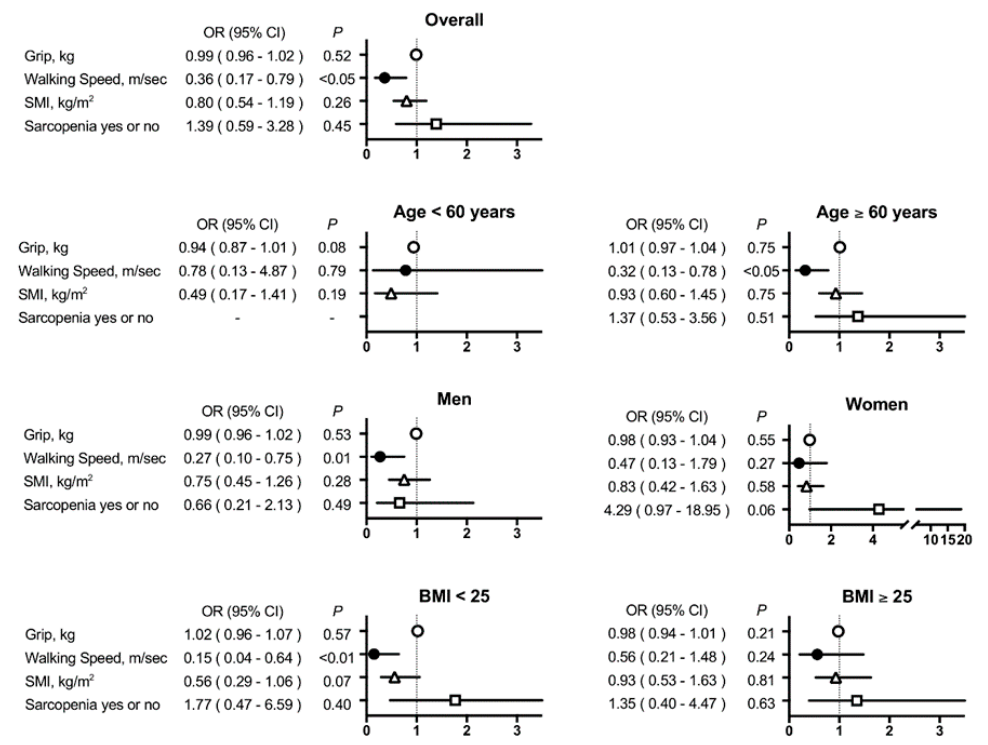
Figure 1. Adjusted odds ratio (OR) for mild cognitive impairment (MCI) (Model 4). ORs